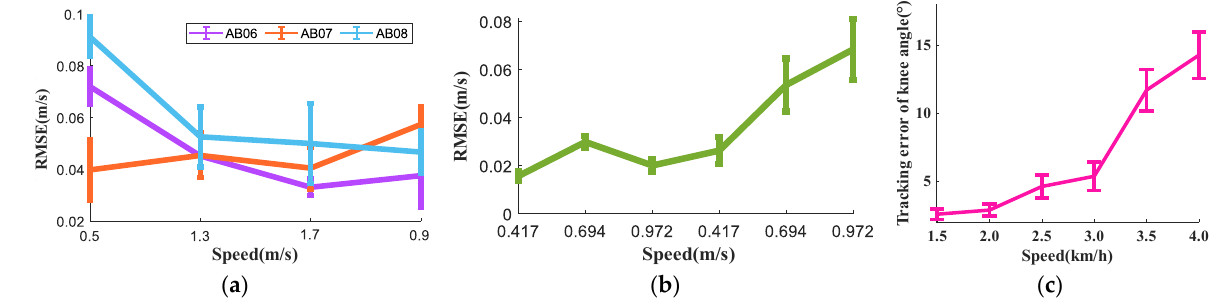
Figure 6. Experimental results based on the AB dataset. ( a ) Speed tracking results. ( b ) Step frequency estimation of AB06. ( c ) Stride estimation of AB06.